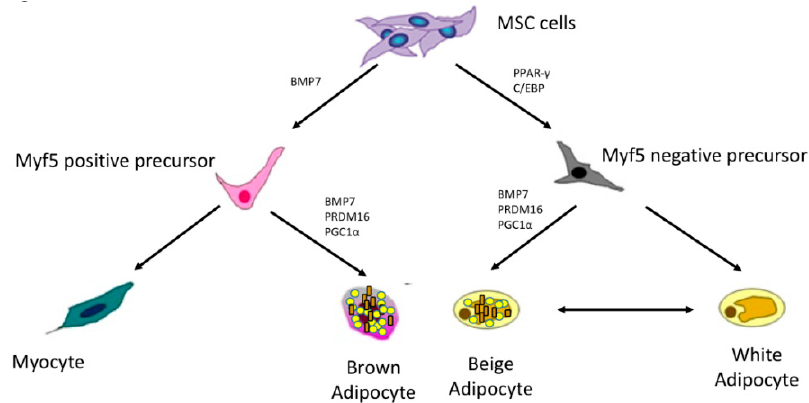
Figure 1. Brown, white, and adipocytes lineages. (Mesenchymal stem cells (MSC) give rise to myogenic factor 5 (Myf5) positive and negative precursors. Myf5 positive precursors generate brown adipocytes under the effect of bone morphogenetic protein 7 (BMP7), PR domain containing 16 (PRDM16) and peroxisome proliferator-activated receptor gamma coactivator 1- α (PGC1 α ). Myf5 negative precursors, under the effect of peroxisome proliferator-activated receptor (PPAR- γ ) and CCAAT/enhancer binding protein (C/EBP), generate white and beige adipocytes).